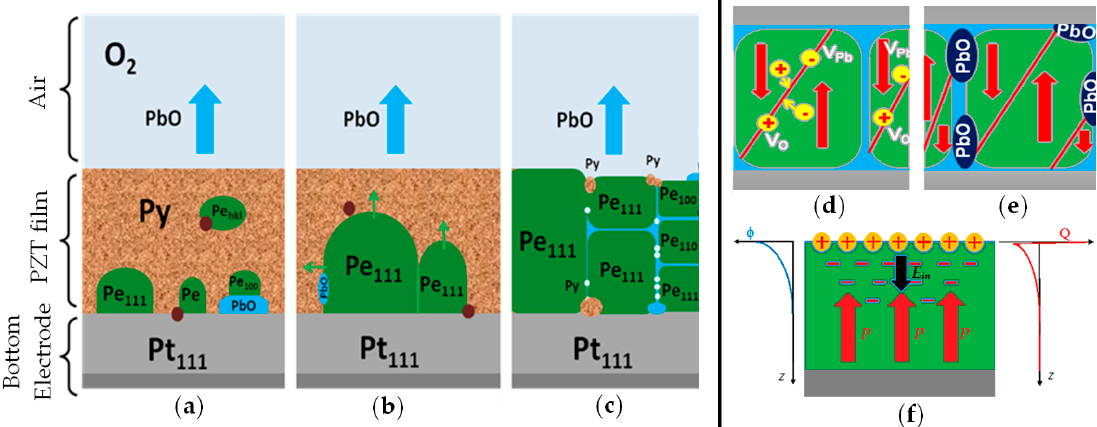
Figure 8. The processes during the formation of PZT films at the annealing and the effect of local stoichiometry disturbances on the polarization pinning in the resulting PZT films: ( a ) nucleation of the perovskite (Pe) phase in a pyrochlore (Py) or amorphous matrix on various inhomogeneities; ( b ) growth of perovskite crystallites; ( c ) grain boundary segregation of PbO λ ; ( d ) domain wall pinning in PZT grains by ionized vacancies; ( e ) PbO λ inclusions and polarization pinning; ( f ) self-polarized film due to the double charge defect layer.